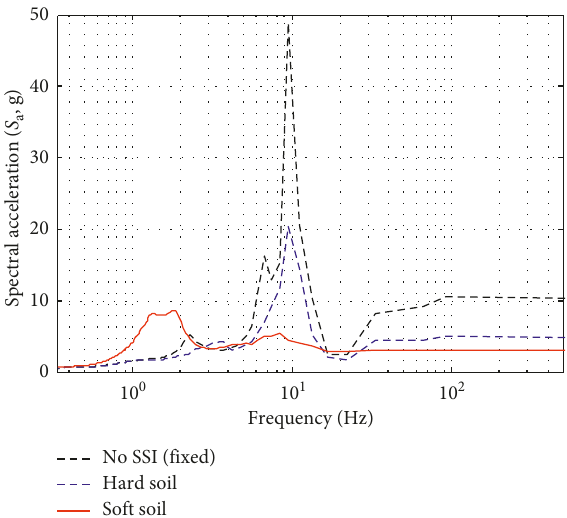
Figure 9: Mean floor response spectra at the top of the internal structure.